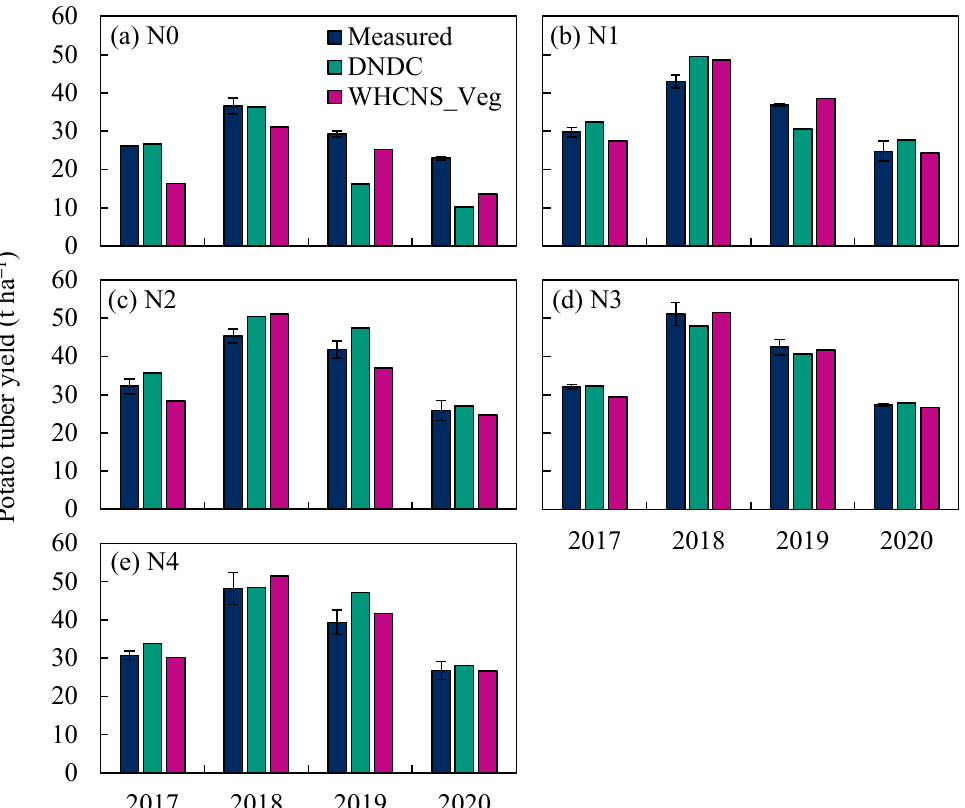
Figure 1. Measured and simulated potato tuber fresh yield from 2017 to 2020 for different N application treatments using the DNDC and WHCNS_Veg models in Wuchuan, China. ( a ) N0 treatment; ( b ) N1 treatment ( c ) N2 treatment ( d ) N3 treatment ( e ) N4 treatment. Vertical bars are standard deviations ( n = 3). The N3 treatment was used to the calibrate the model parameters. Table 3. Statistical calibration between the simulated and measured potato tuber yield, above-ground biomass and